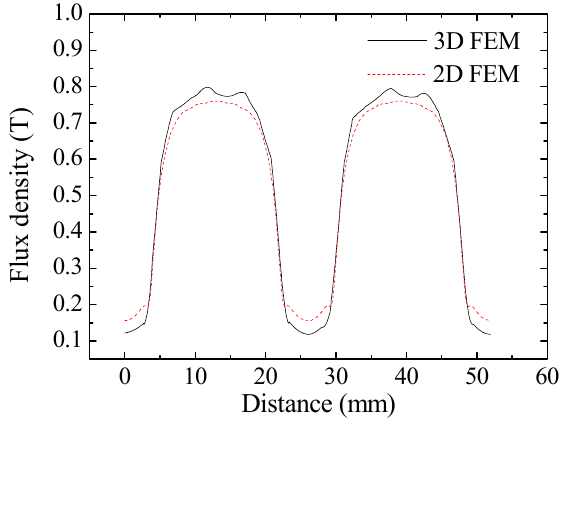
Figure 14. Inner air gap flux density from 2D and 3D